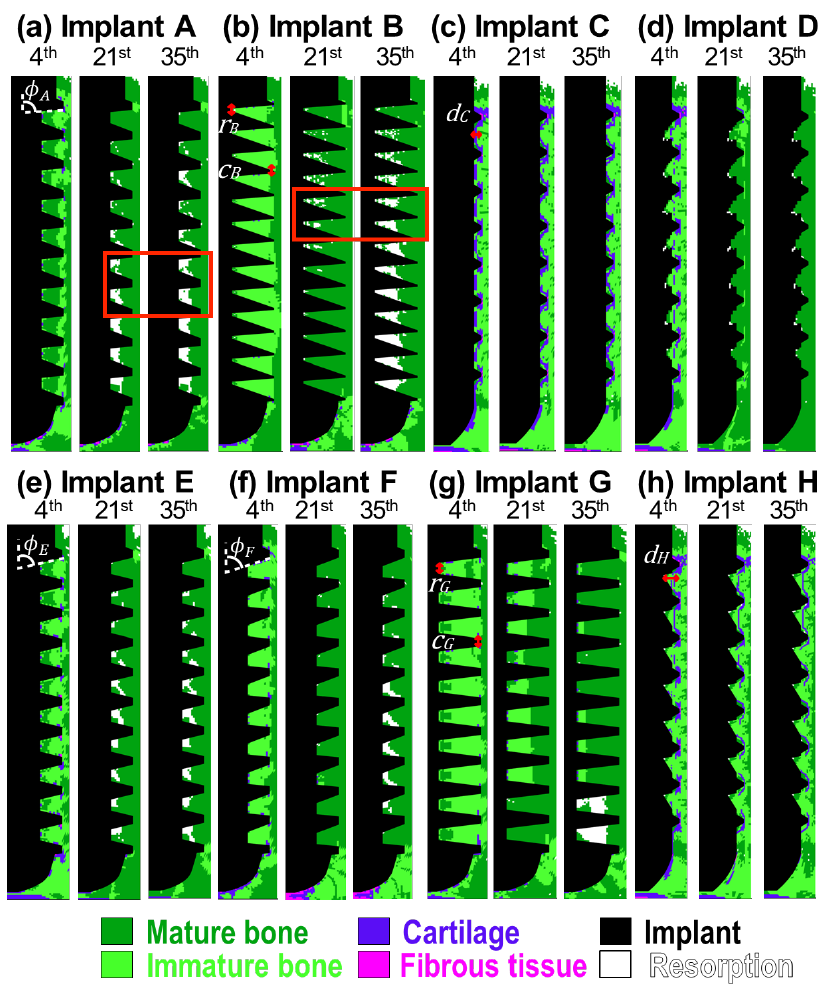
Figure 1. ( a – h ) The predicted history of the bone ingrowth and cell differentiation around implant A to